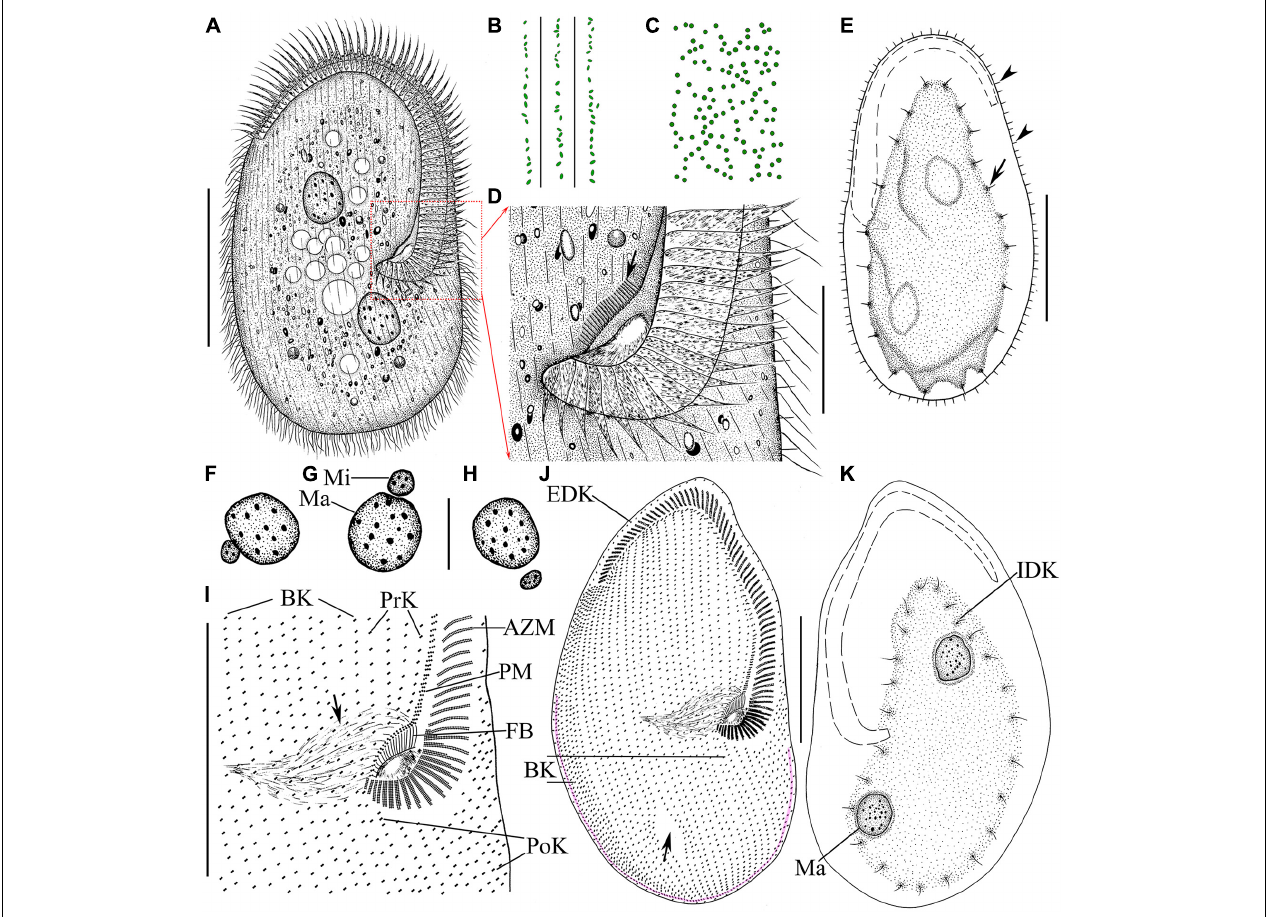
FIGURE 4 | Morphology and infraciliature of Peritromus kahli population-I [ (A–E) , in vivo ] and population-II [ (F–K) , after protargol staining]. (A) Ventral view of a typical individual. (B,C) The arrangement of the type I (smaller, oval) and type II (larger, round) cortical granules. (D) Detail of oral area; arrow indicates fiber bundles. (E) Dorsal view of an individual; arrowheads indicate the external dorsal kinetids, and arrow indicates the internal dorsal kinetids. (F–H) Various juxtapositions of macronuclear nodules and micronuclei. (I) Detail of oral area showing the infraciliature; arrow indicates cytopharynx. (J , K) Ventral (J) and dorsal (K) view of the infraciliature; the pink line depicts the caudal margin kinety, and arrow indicates a wide gap (putative cytoproct). Abbreviations: AZM, adoral zone of membranelles; BK, bipolar kineties; EDK, external dorsal kinety; FB, fiber bundles; IDK, internal dorsal kinety; Ma, macronucleus; Mi, micronucleus; PoK, postoral kineties; PM, paroral membrane; PrK, peroral kineties. Scale bars = 50 µ m (A , E , I–K) , 15 µ m (D , F–H)